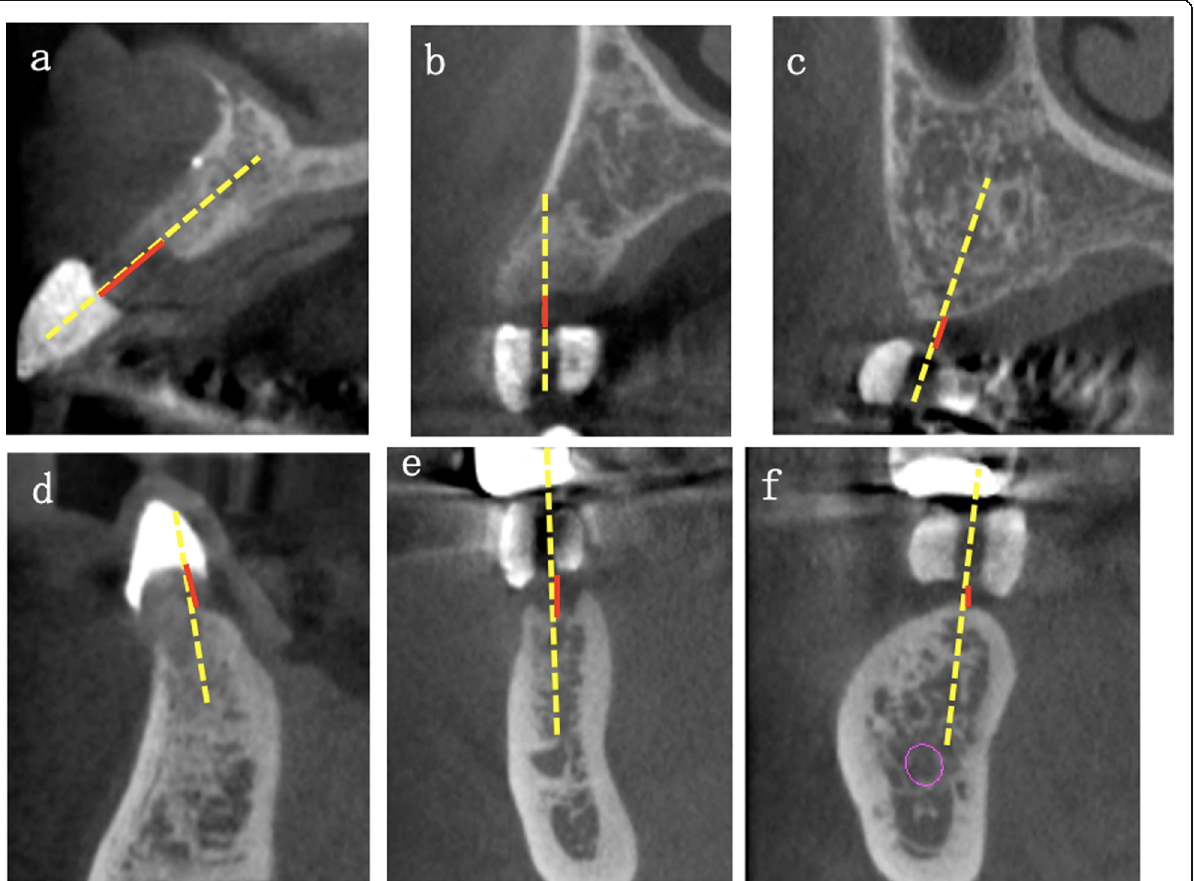
Fig. 2 Cross-sectional image. The yellow dotted line indicates the ideal direction of implant insertion, as determined based on the radiographic stent, and set as the long axis. Red lines indicate the mucosal thickness as measured from the base of artificial teeth of the diagnostic template to the surface of the alveolar bone. a Maxillary anterior region. b Maxillary premolar region. c Maxillary molar region. d Mandibular anterior region. e Mandibular premolar region. f Mandibular molar